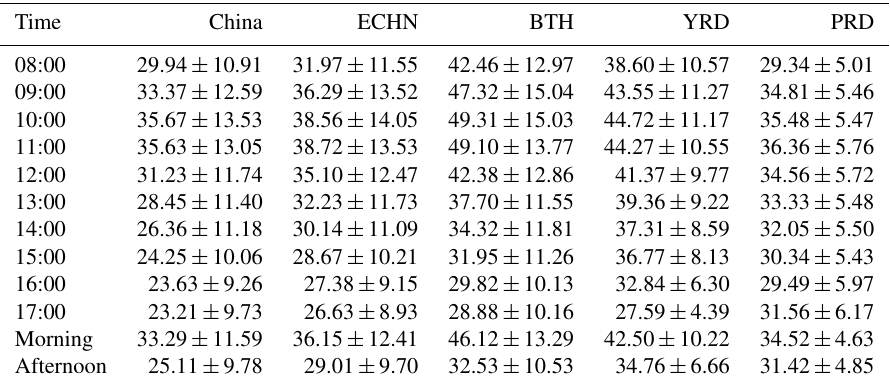
Table 2. Hourly mean PM 2 . 5 concentrations (µgm − 3 ) in 2018 in China, eastern China (ECHN), the Beijing–Tianjin–Hebei (BTH) region, the Yangtze River Delta (YRD), and the Pearl River Delta (PRD). Time